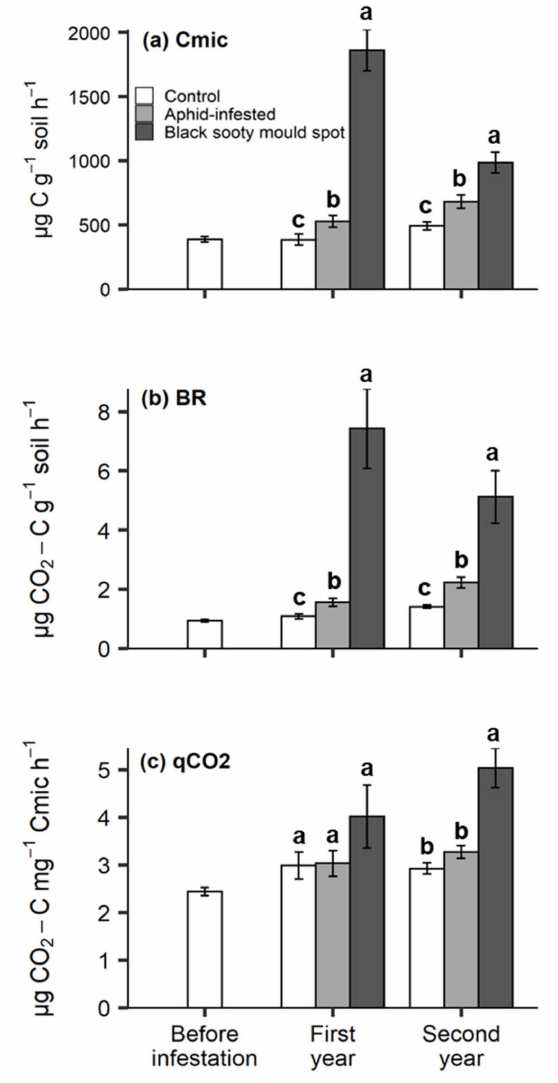
Figure 5. The e ff ect of T. salignus honeydew deposition on ( a ) soil microbial biomass ( µ g C g − 1 soil), ( b ) basal respiration ( µ g CO 2 -C g − 1 soil h − 1 ), and ( c ) metabolic quotient over time ( µ g CO 2 -C µ g − 1 Cmic h − 1 ), prior to aphid inoculation (before infestation), and after aphid inoculation (control, aphid-infested, and black sooty mould spots) in the first and second year. The values are the means ± SE. Di ff erent letters indicate statistically significant di ff erences at each sampling time (Tukey’s HSD test, α =